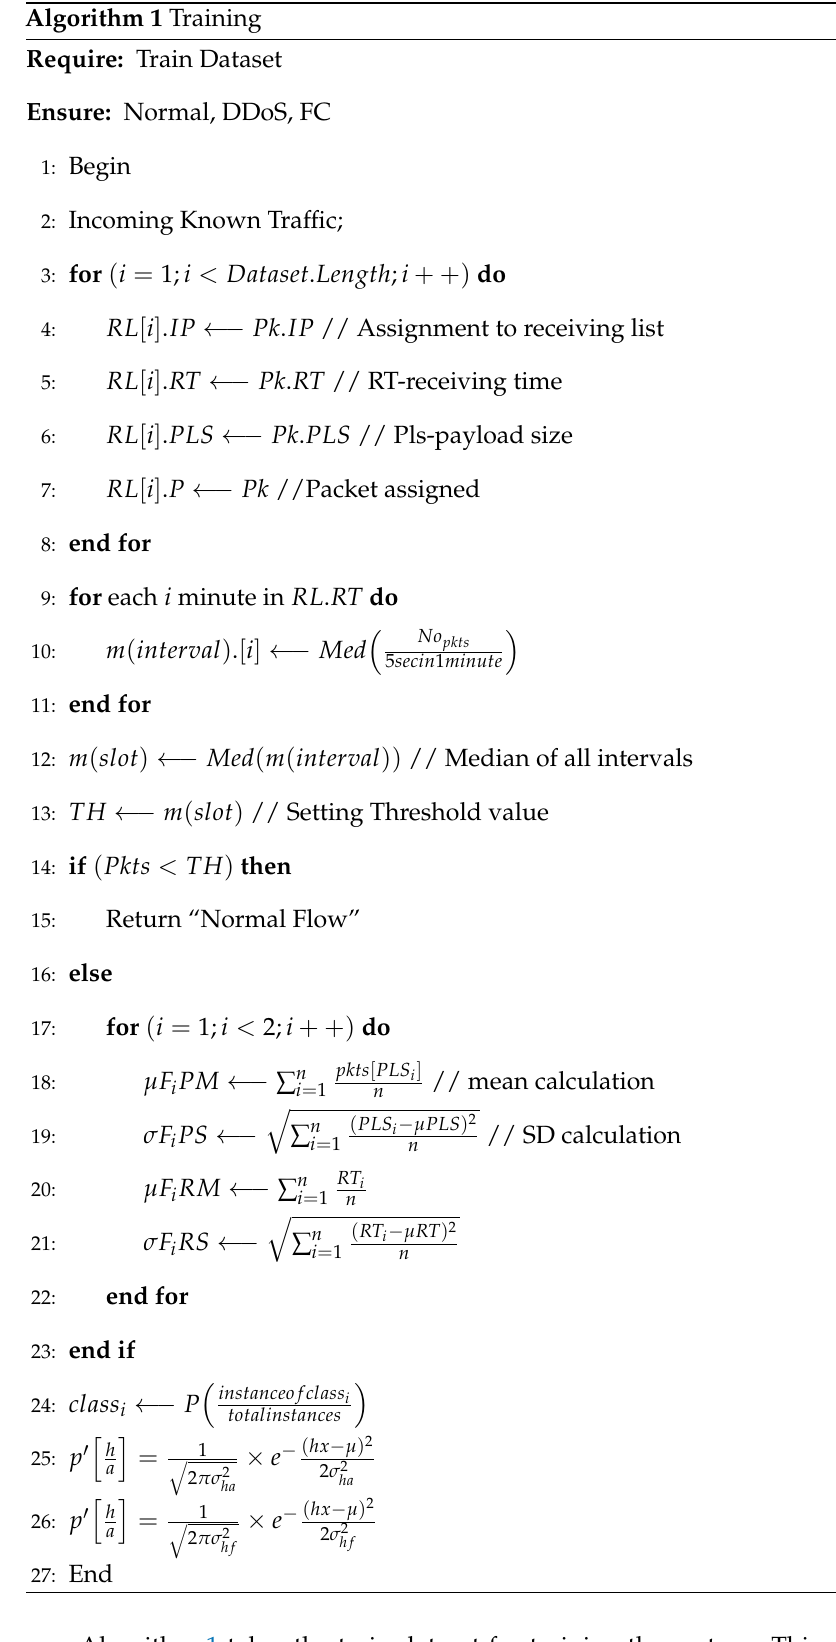
Algorithm 1 takes the train dataset for training the system. This algorithm